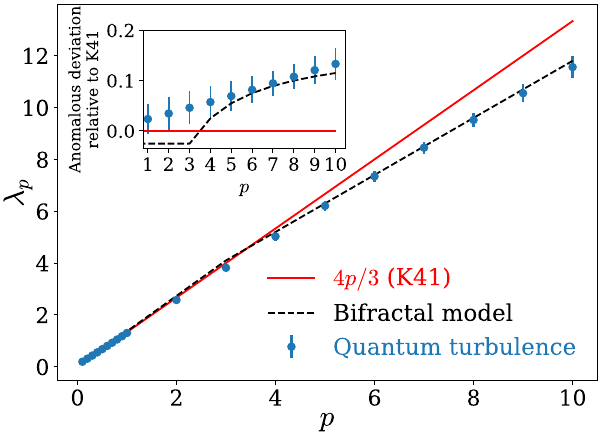
FIG. 5. Scaling exponents of the circulation moments for loop sizes within the classical range ( l ≪ r ≪ l ). Blue circles with I error bars correspond to gGP simulations. The solid line shows 4 p= 3 , and the dashed line shows the bifractal K41 scaling λ K 41 p ¼ fit in classical turbulence [20]. Inset: relative deviation from K41 − λ = λ K 41 estimates, ð λ K 41 . Error bars indicate the standard p p p Þ deviation of each λ within the classical p